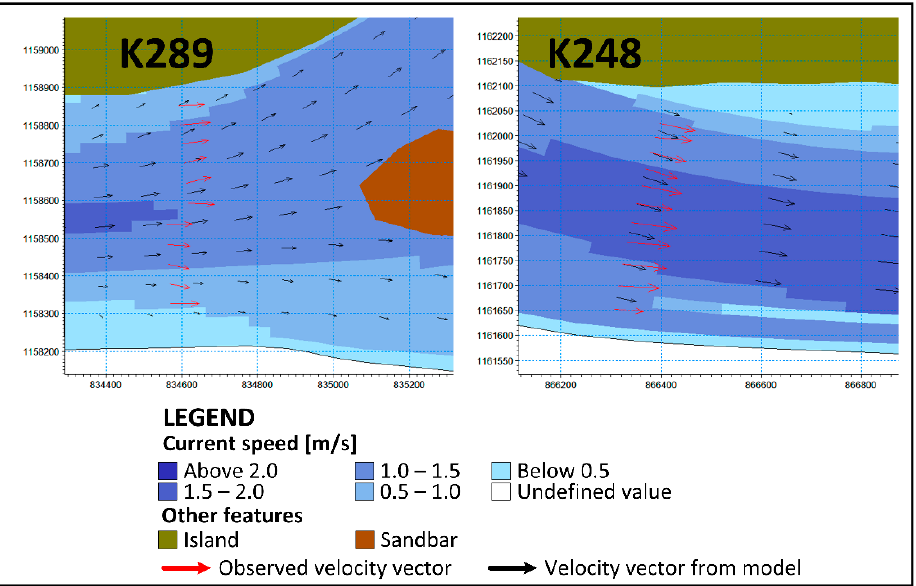
Figure 7. Comparison between Velocity Vectors in two sections of the reach for the optimal case.